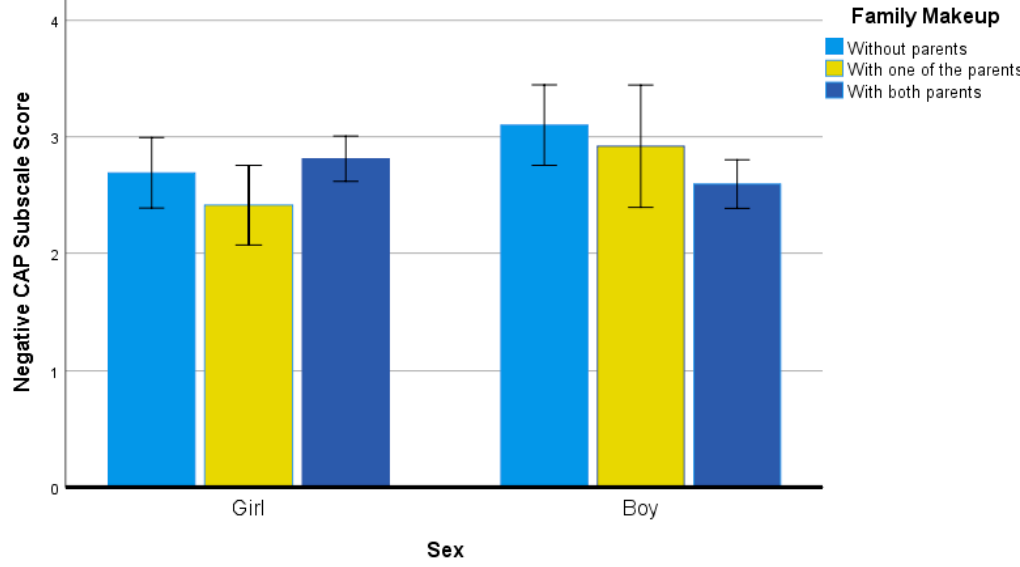
Figure 2. Negative CAP Subscale Scores for Sex and Family Makeup Groups. The last significant ( p < 0.05) two-way interaction concerned sport type by family makeup, F (2, 314) = 2.91, p = 0.05, η 2 = 0.02. When examining Figure 3, individual sport participants without parents and with one parent self-reported higher levels of negative PNPCAP scores. Effect size values referenced to individual sport participants residing without parents were as follows: individual sport residing with both parents ( g = 0.40), team sport residing without parents ( g = 0.25), team sport residing with one parent ( g = 0.71), and team sport residing with both parents ( g = 0.31). Effect size values referenced to individual sport participants were as follows: individual sport residing with both